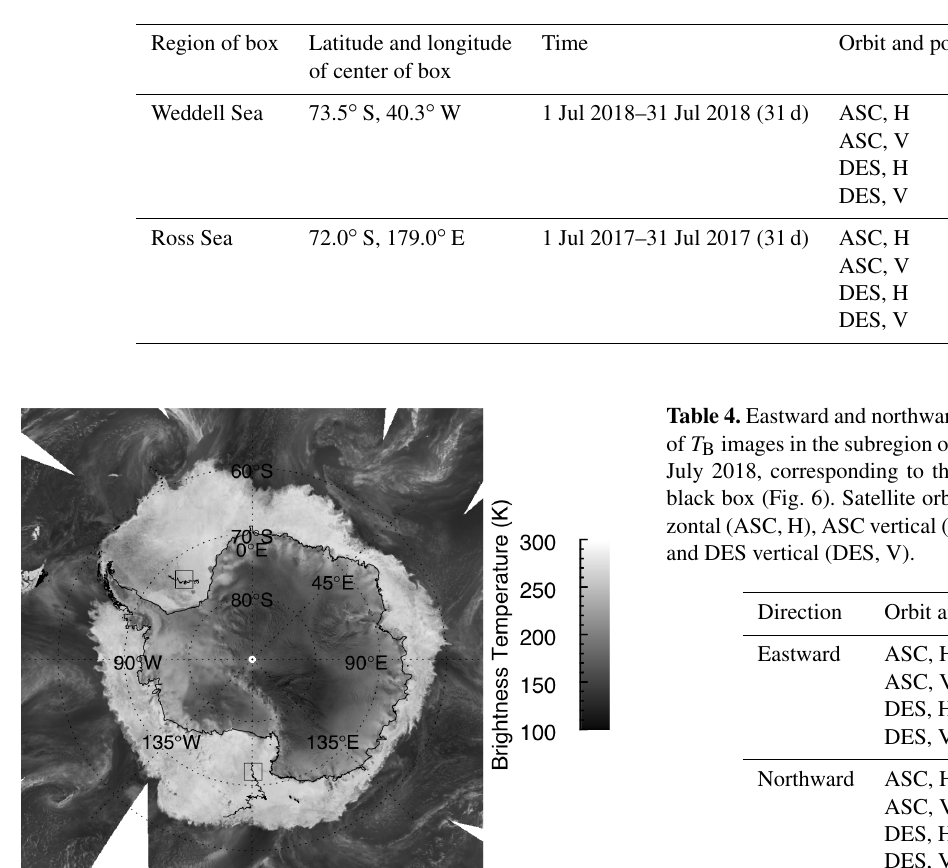
Table 3. Standard deviation of T B for subregions in the Weddell Sea and Ross Sea shown in Fig. 6. Time periods are the corresponding time of buoys within these subregions. Satellite orbits and polarizations are ASC horizontal (ASC, H), ASC vertical (ASC, V), DES horizontal (DES, H), and DES vertical (DES, V).